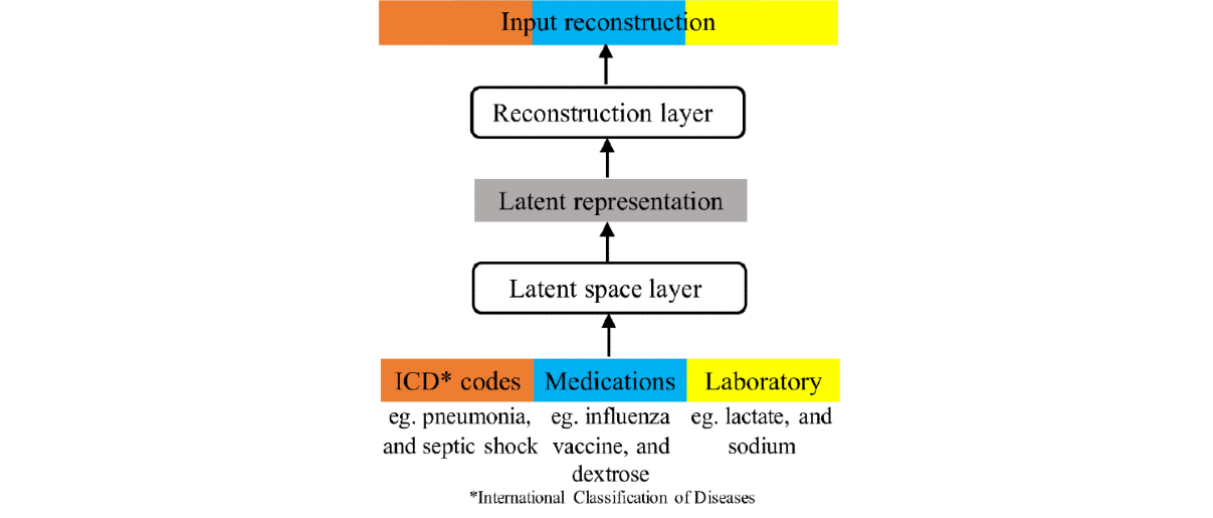
Figure 3. The correlational neural network for our 3 views. ICD: International Classification of